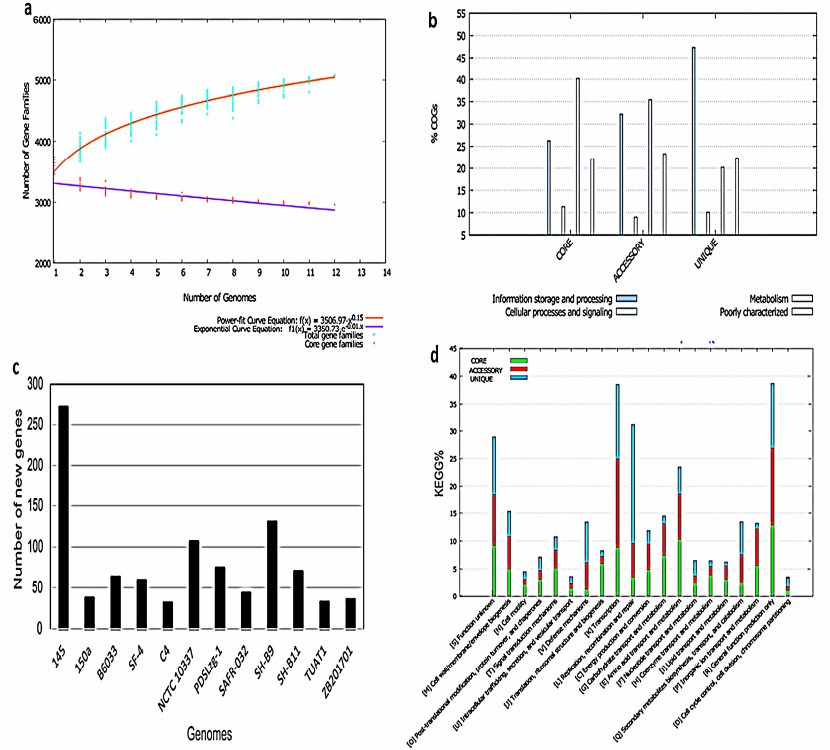
Figure 2. Pan-genome analysis of all B. pumilus strains ( n = 12). ( a ) Represent the core and pan-genome plot. ( b ) The cluster of orthologous groups (COGs) distribution of representative genes in the unique, core, and accessory genome ( c ) shows the number of new genes added to each genome. ( d ) Kyoto encyclopedia of genes and genomes (KEGG) distribution in the unique, accessory, and core